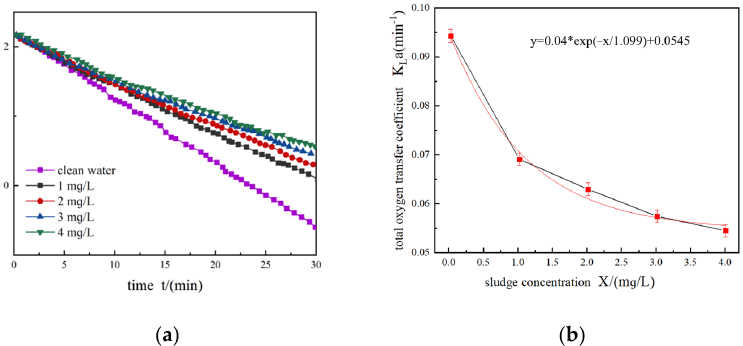
Figure 12. Logarithmic oxygen deficit and total oxygen transfer coefficient at different sludge concentrations: ( a ) logarithmic oxygen deficit; ( b ) total oxygen transfer coefficient.